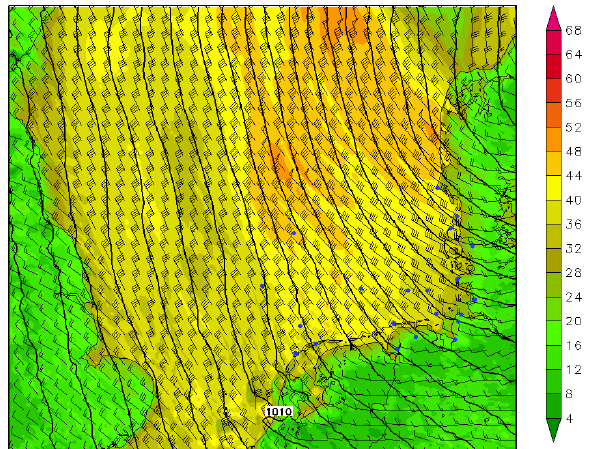
Figure 3. Wind field over the North Sea of storm “Tilo” at 9 November 2007, 06:00 UTC, 3h before the water reached the high- est level at Norderney. Shown is a COSMO-de nudging run. The wind 10m above ground is shown in knots. As contour lines p.m.s.l. is shown in 2hPa intervals. The blue dots show the locations of the stations which were used for